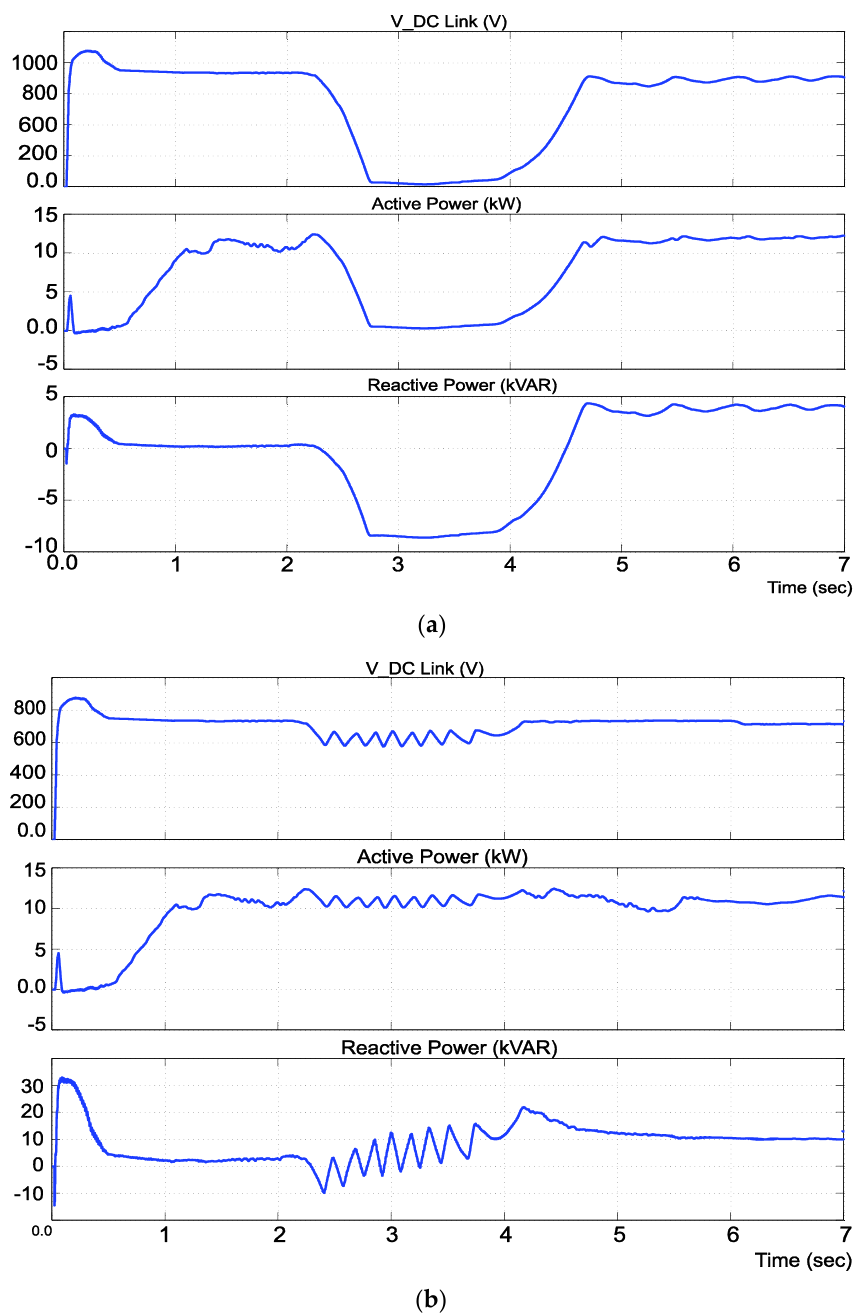
Figure 10. DC voltage and active and reactive power variation in VAR tracking mode with step change in reference reactive power at t = 2 s from 3 kVAR to 10 kVAR using: ( a ) conventional control; and ( b ) proportional HBC.